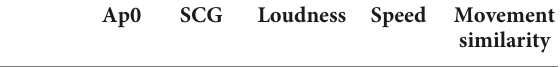
TABLE 6 Pearson correlations between all physical auditory and visual